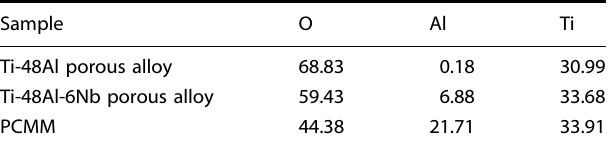
Table 4. EDS composition analysis of porous sample after isothermal sul fi dation